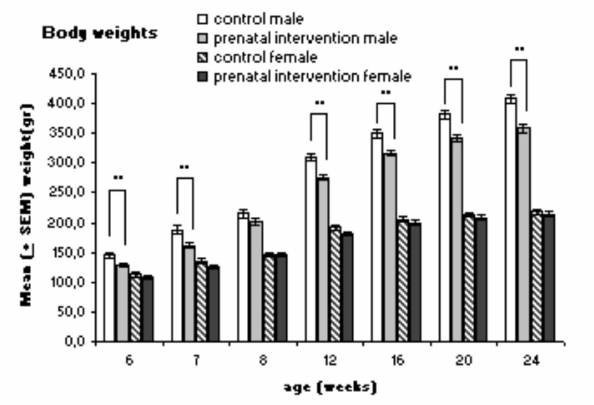
Figure 1 - Weight gains of male and female controls and prenatally interven- tioned Fisher rats. All animals were repeatedly weighed between PD 42 and PD 168. Depicted is the weight at weeks 6, 7, 8, 12, 16, 20 and 24. Female rats gained less weight over the course of 24 weeks than the males. The male control (n = 8) and prenatal intervention (n = 16) groups gained more weight over the course of 24 weeks than the females. In contrast to males, female controls (n = 10) did not differ from the female prenatal intervention group (n = 14) *p ≤